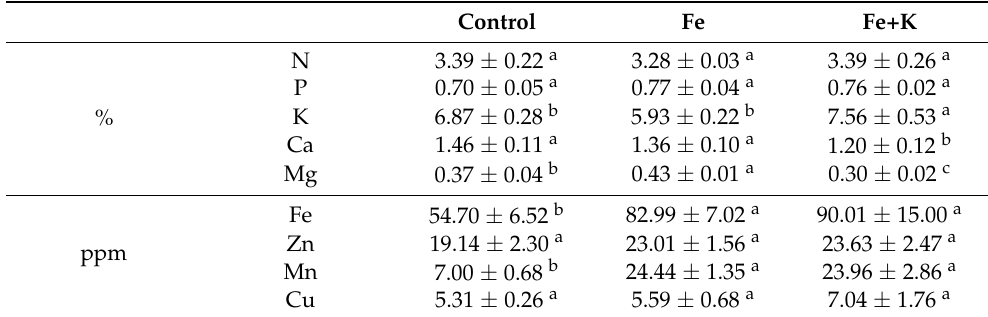
Figure 4. Photosynthetic light-response curves of lettuce ( a ) Day 7; ( b ) Day 21; ( c ) Day 42 (Mean ± SD, n = 8) and their respective maximum photosynthetic rates (Amax), quantum yield of photosynthesis (a) and dark respiration (Rd) at the side tables. Means in a row followed by different letters are significantly different ( p < 0.05). Table 5. Nutrient composition of lettuce leaves at the final harvest (Mean ± SEM, n = 4). Different superscripts in a row denote statistically significant differences among treatments ( p <